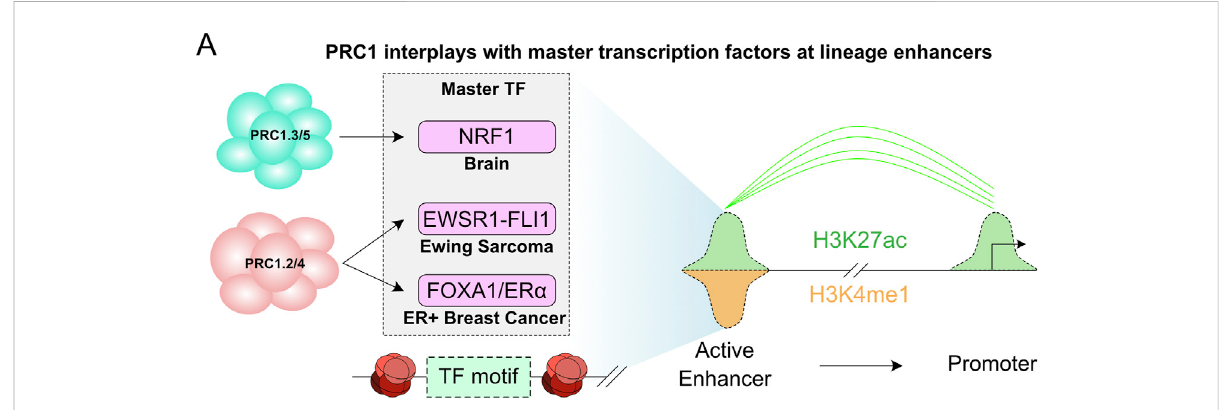
FIGURE 4 Polycomb at distal regulatory elements to support gene transcription. (A) Illustration of the interplay between PRC1 and master transcription factors showing their requirement for enhancer activity in different disease and tissue